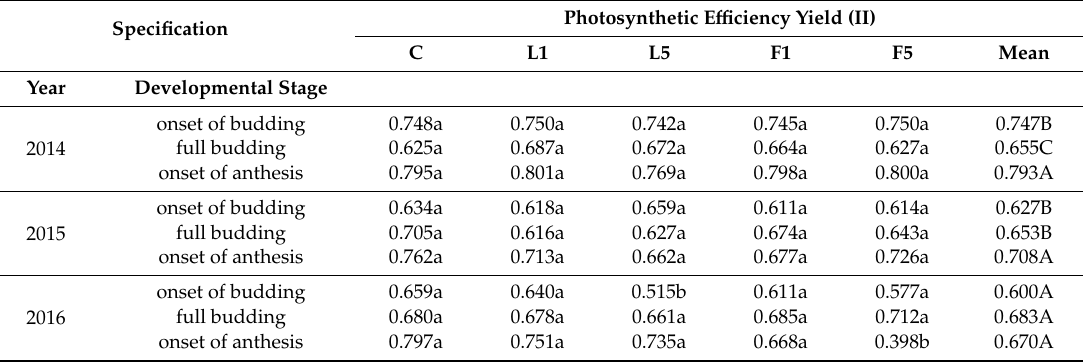
Table 2. Influence of electromagnetic stimulation on photosynthetic e ffi ciency.